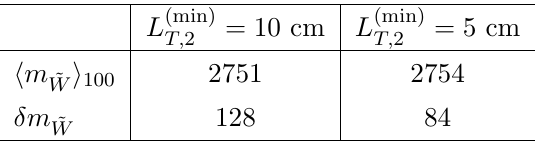
Figure 5 . Distribution of the reconstructed Wino mass for the chargino pair production process, taking L (min) = 10 cm (left) and 5 cm (right) in a single experiment with the integrated luminosity T; 2 of L = 30 ab (cid:0) 1 .